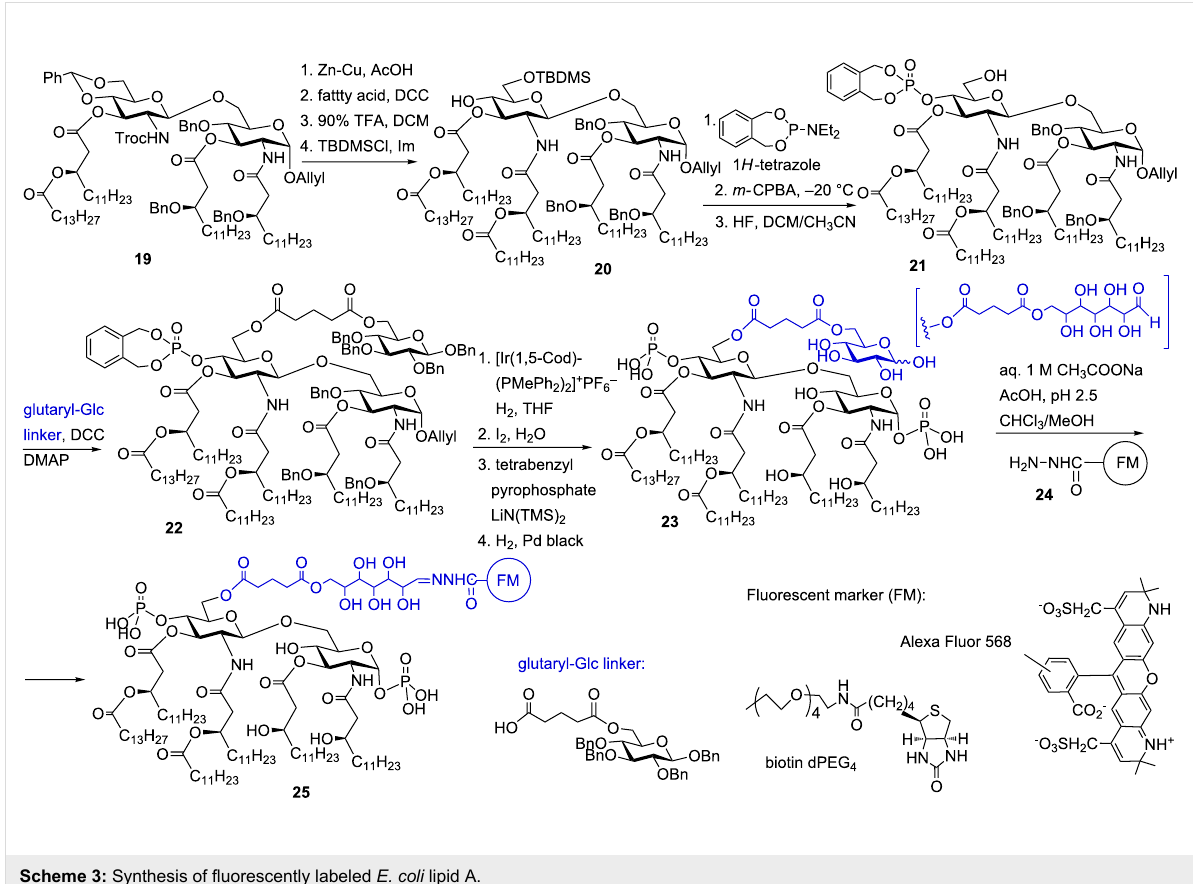
Scheme 3: Synthesis of fluorescently labeled E. coli lipid